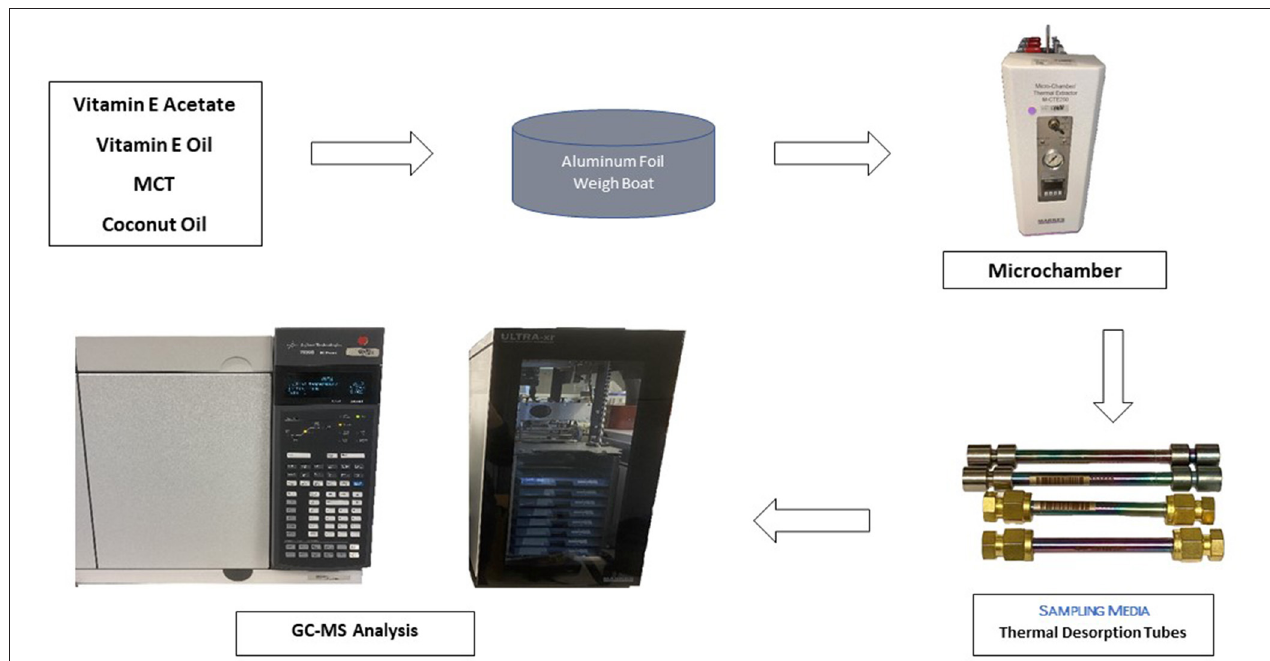
FIGURE 1 | Flow diagram of emission testing of oil